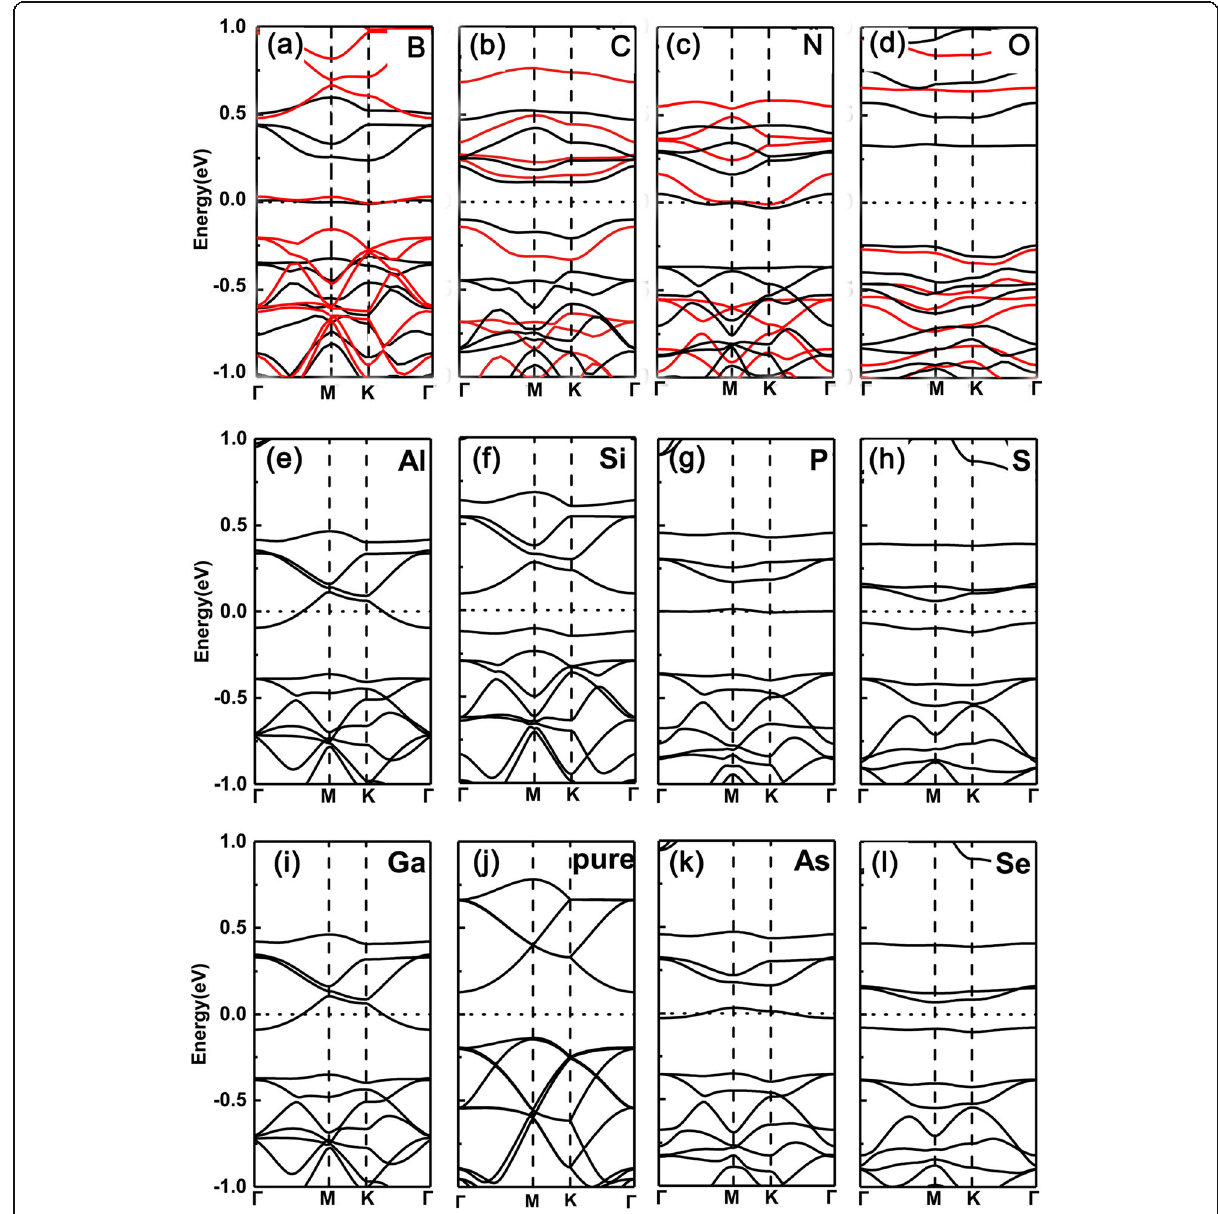
(cid:2) 2 supercell with various dopants in GeP 3 , k As, l Se. Calculated band structures for a 2 3 monolayer from group III to VI, with substituting Ge atom, respectively, together with that of pure GeP 3 monolayer. Both the PBE and HSE06 functionals are employed in the topmost